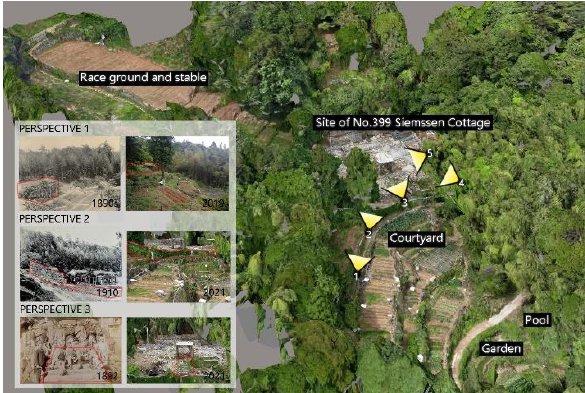
Figure 3 A 3D-Model of the Siemssen & Krohn Co. cottage